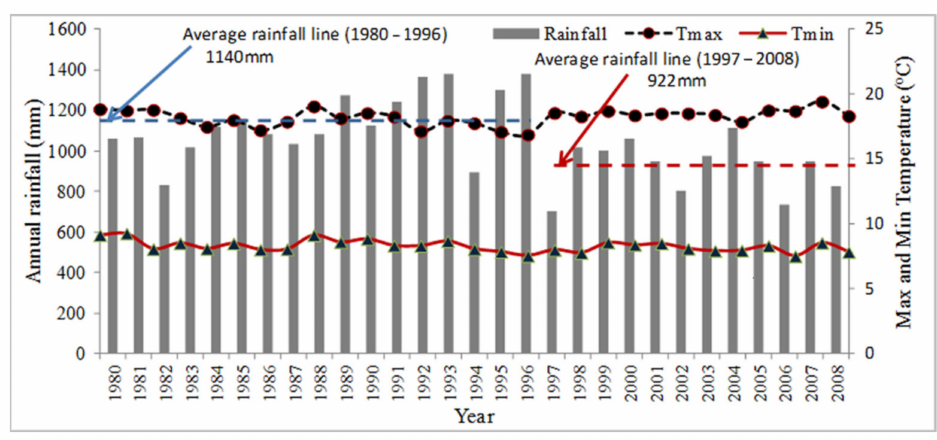
Figure 4. Annual rainfall and temperature (max and min) in the MYD